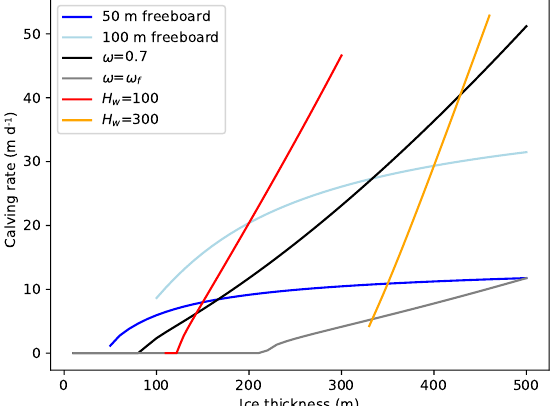
Figure 11. Calving rates predicted by the parametrization in rela- tion to ice thickness. Calving rates increase with increasing total ice thickness for a given water depth H w = ωH (red and orange lines), relative water level ω (black and gray lines) or freeboard H − H w (blue lines). Note that the gray line refers to a front at flotation.